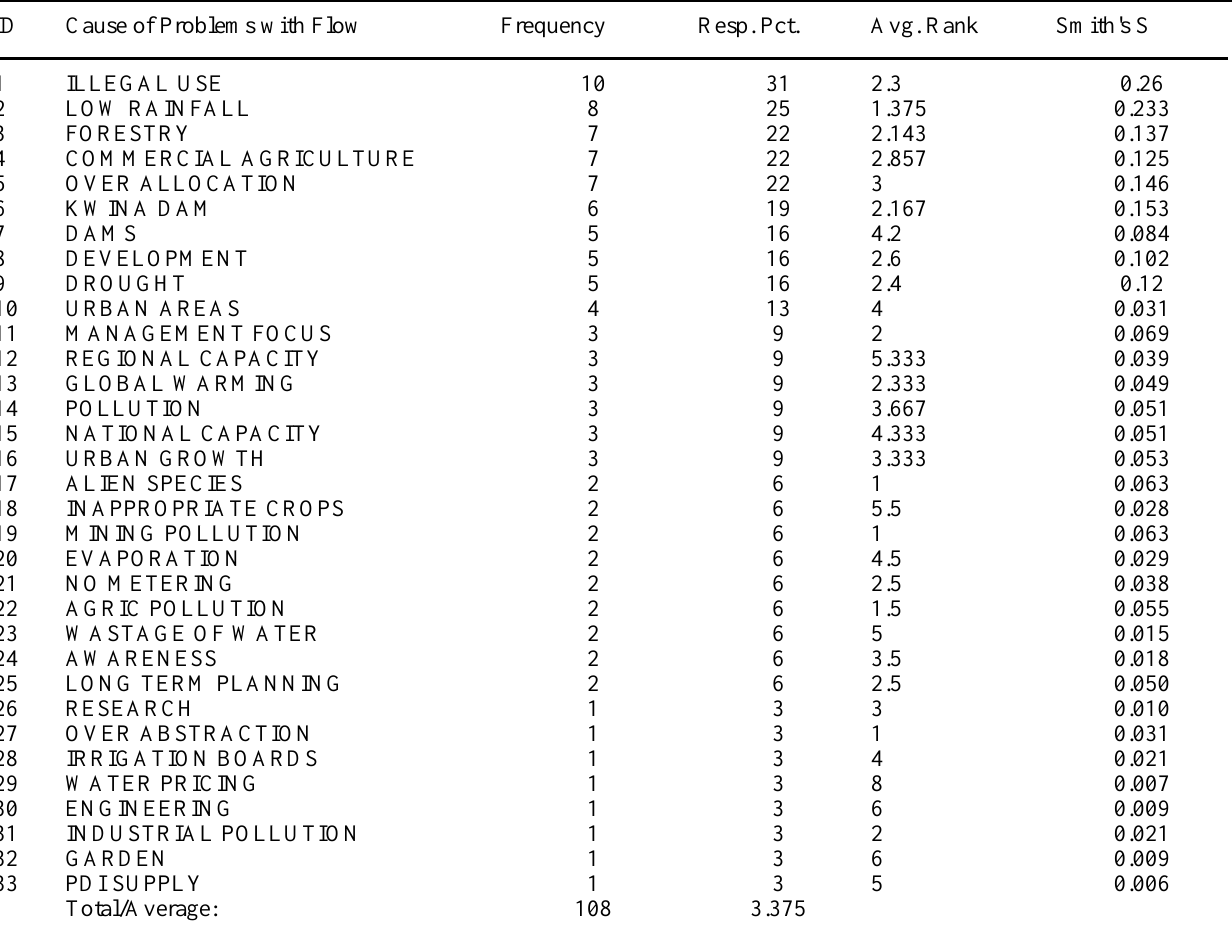
Table 4 . Results of analysis of freelists of “causes of the problems with current flows in the Crocodile River”, showing frequency with which interviewees identified causes, the percentage of interviewees who identified that cause, the average ranking of that cause, and the salience (Smith's S) of the cause. ID Cause of Problems with Flow Frequency Resp. Pct. Avg.